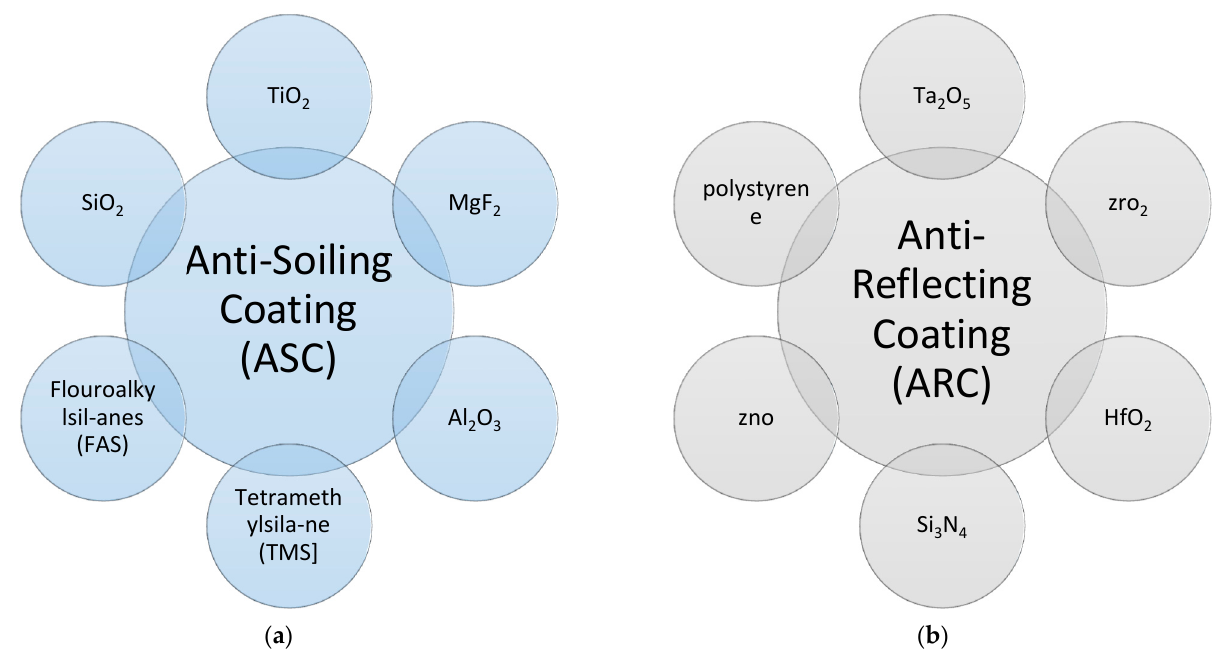
Figure 17. Materials selection: ( a ) currently available anti ‐ soiling materials [75–80], ( b ) currently available anti ‐ reflecting materials [81–86].